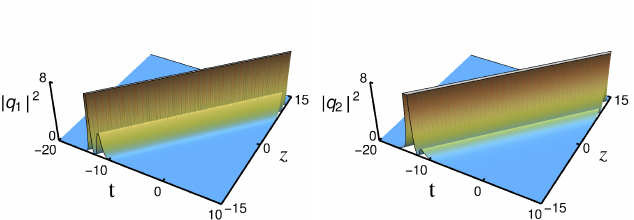
Figure 9. The singular double-hump profiles of the nondegenerate one-soliton solution (39a) and (39b) of the mixed 2-CNLS